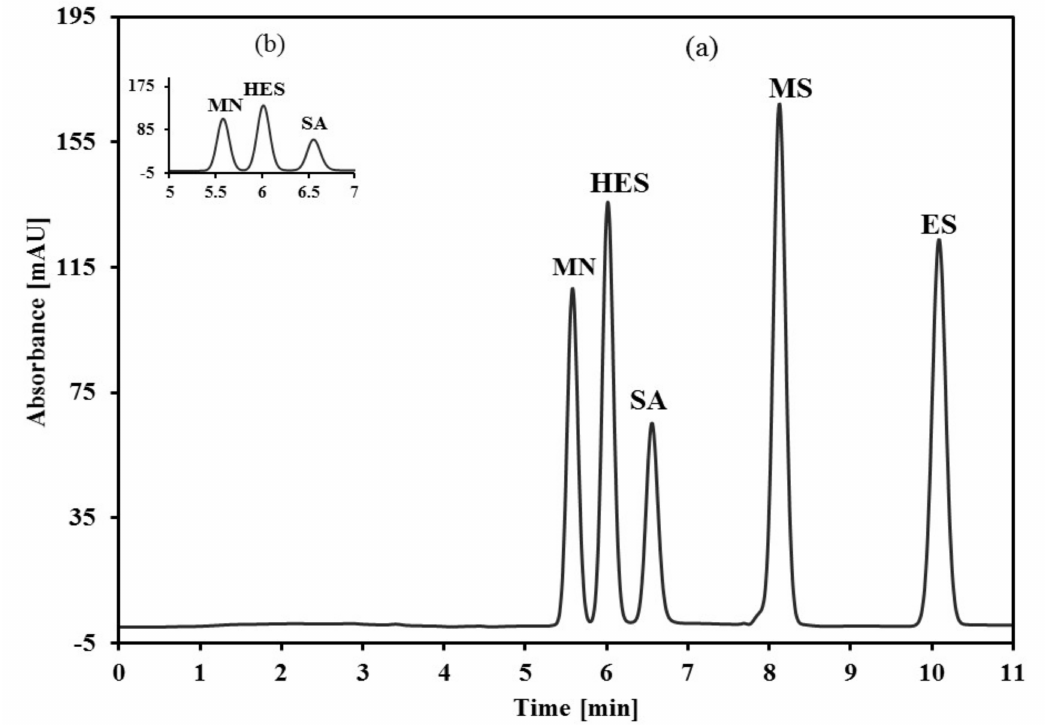
Figure 2. Chromatogram for MN, HES, SA, MS and ES at optimum conditions. ( a ) complete chro- matogram; ( b ) the enlarged view of the scale range from 5 to 7 min.